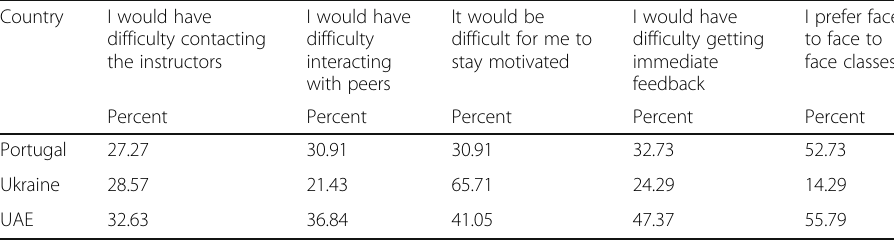
Table 6 Reasons to not enroll in distance education courses (More than one could be chosen) Country